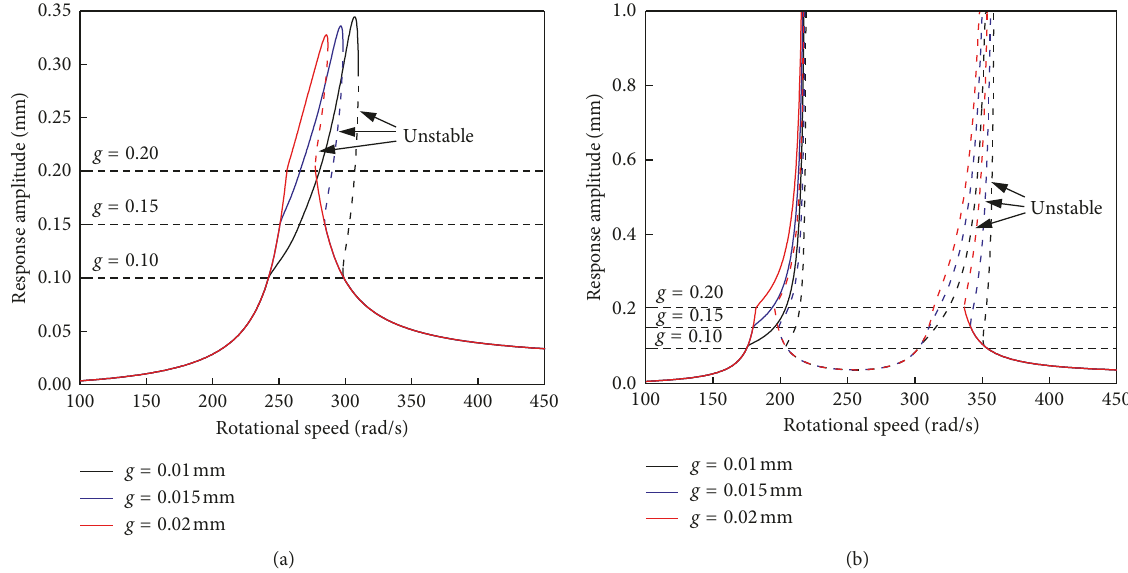
Figure 7: Effects of the gap size on the horizontal amplitudes of disk node: (a) symmetric rotor and (b) asymmetric rotor.